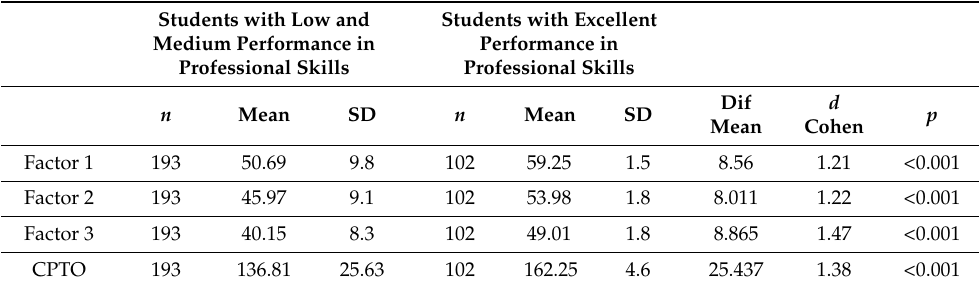
Table 4. Mean scores in students with and without excellent professional skills.